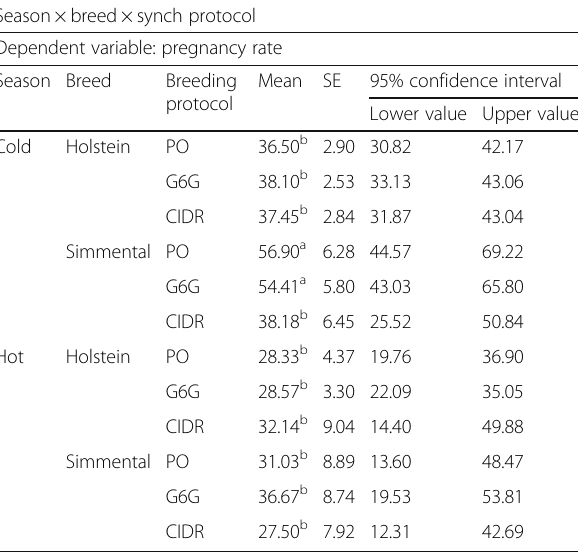
PO Presynch-Ovsynch protocol, CIDR controlled internal drug release, G6G gonadotropin of Presynch, 6days later Gonadotropin of Ovsynch. Values with different superscript letters are significantly different ( p